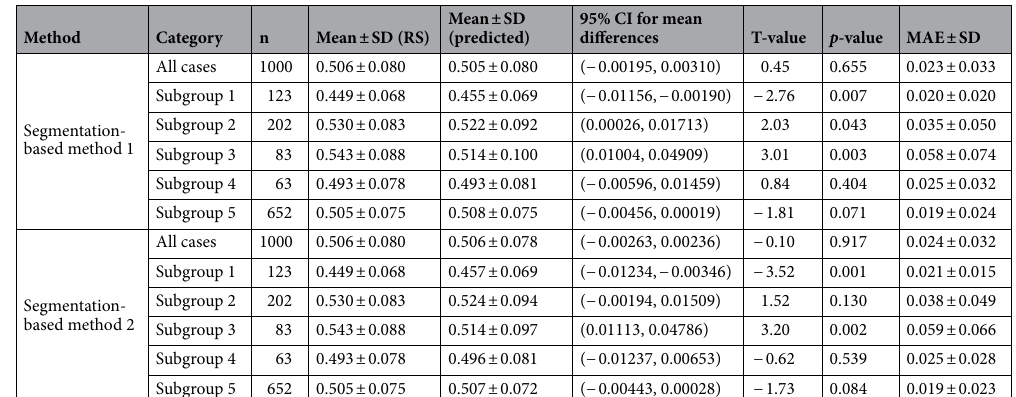
Table 3. Reliability of the cardiothoracic ratio calculation. CI confidence interval, RS reference standard, MAE mean absolute error, SD standard